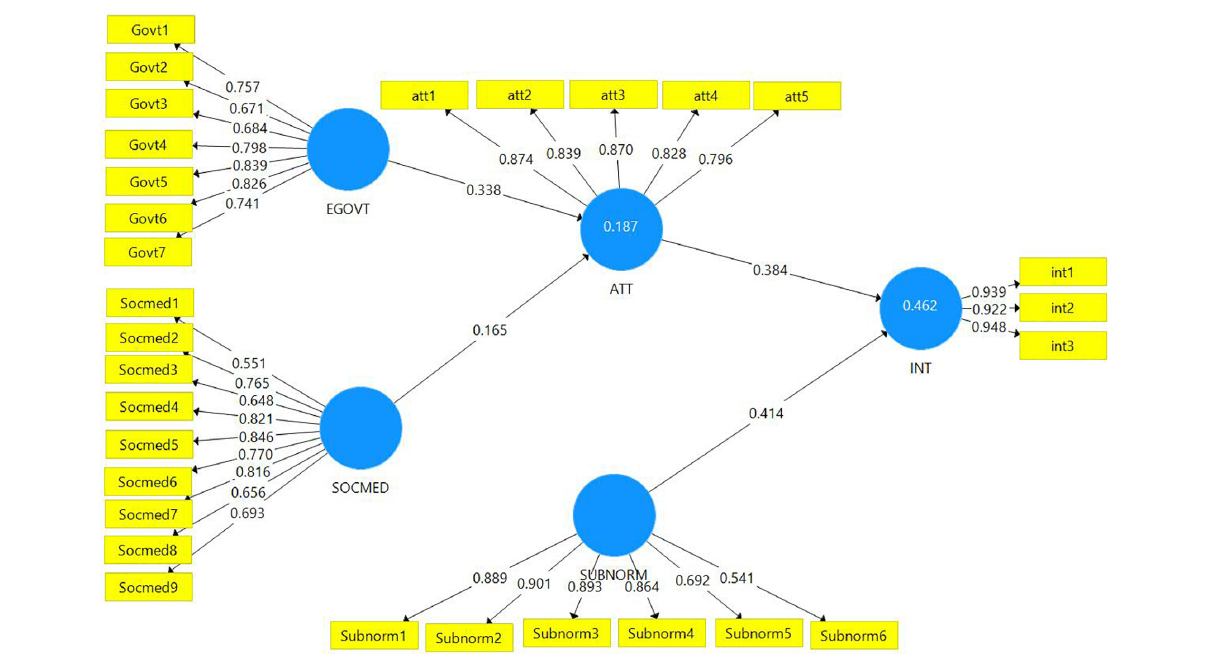
FIGURE 2 | Path coefficients and structural